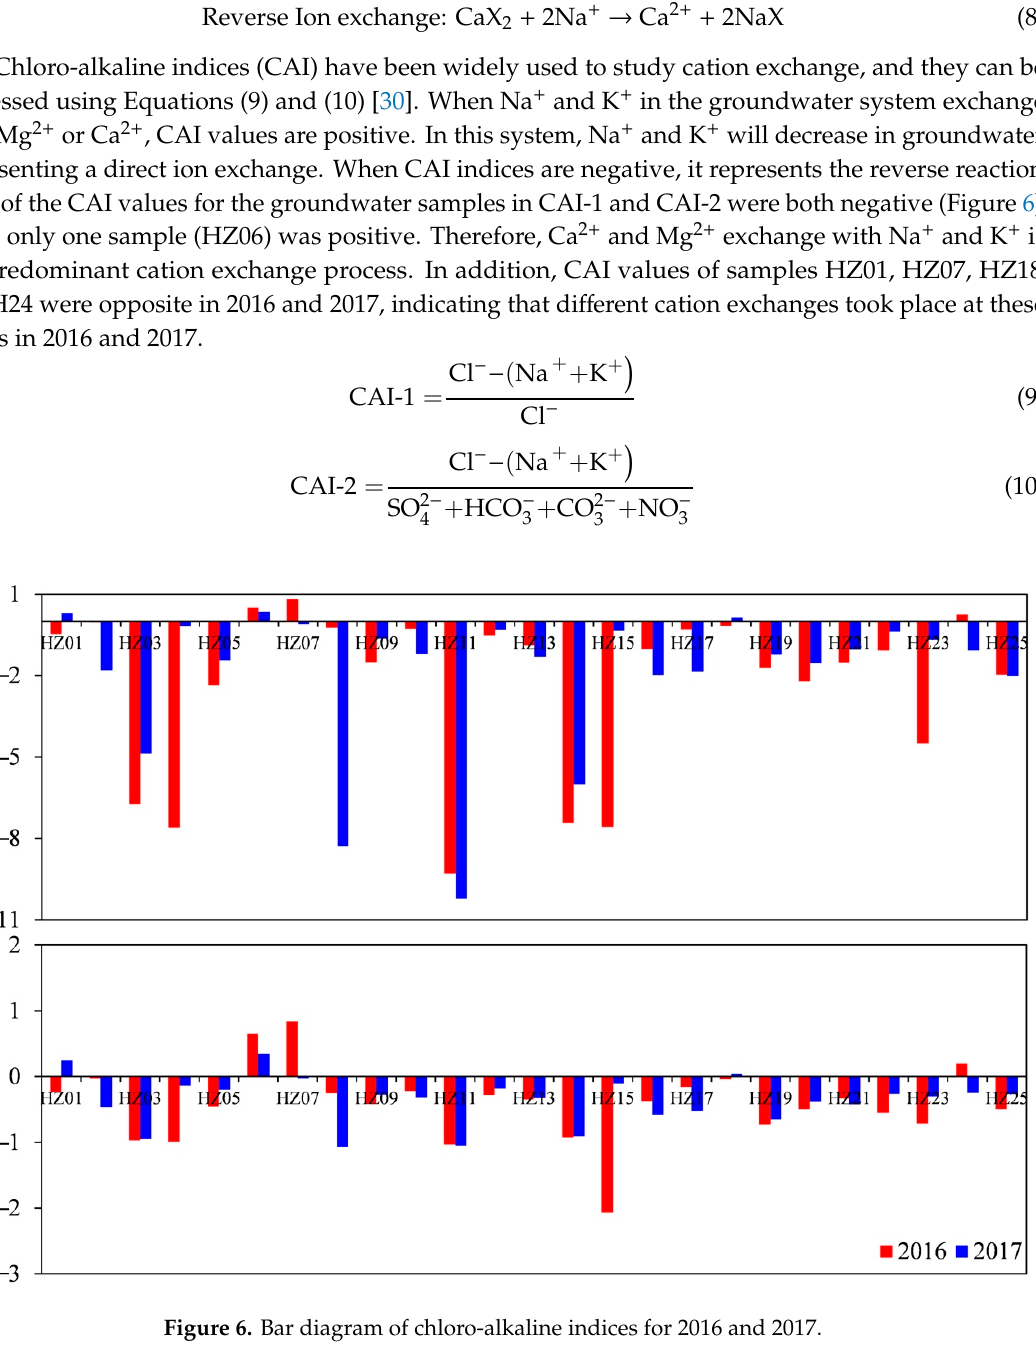
Figure 6. Bar diagram of chloro-alkaline indices for 2016 and 2017.